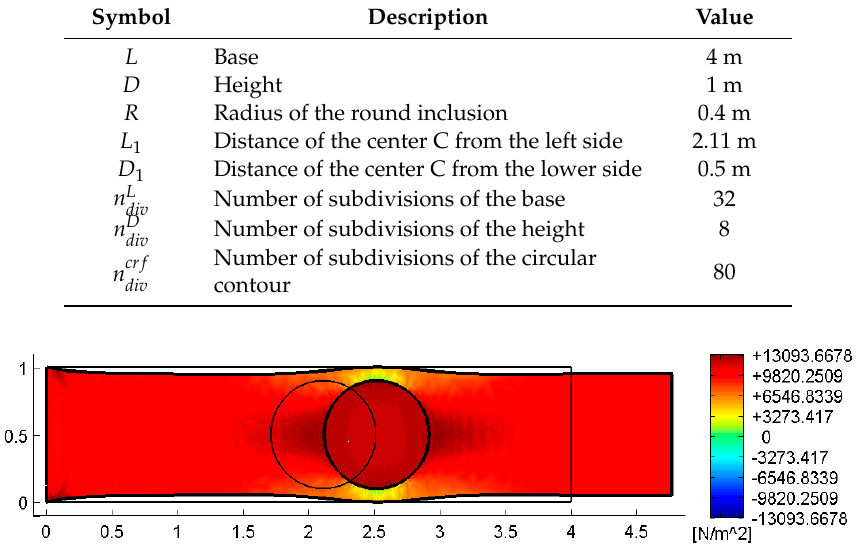
Figure 26. Geometry and loading condition of the elastic cantilever beam with a round inclusion [5]. Table 1. Geometric parameters used to model the beam of Figure 26 [5]. Table 1. Geometric parameters used to model the beam of Figure 26 [5].